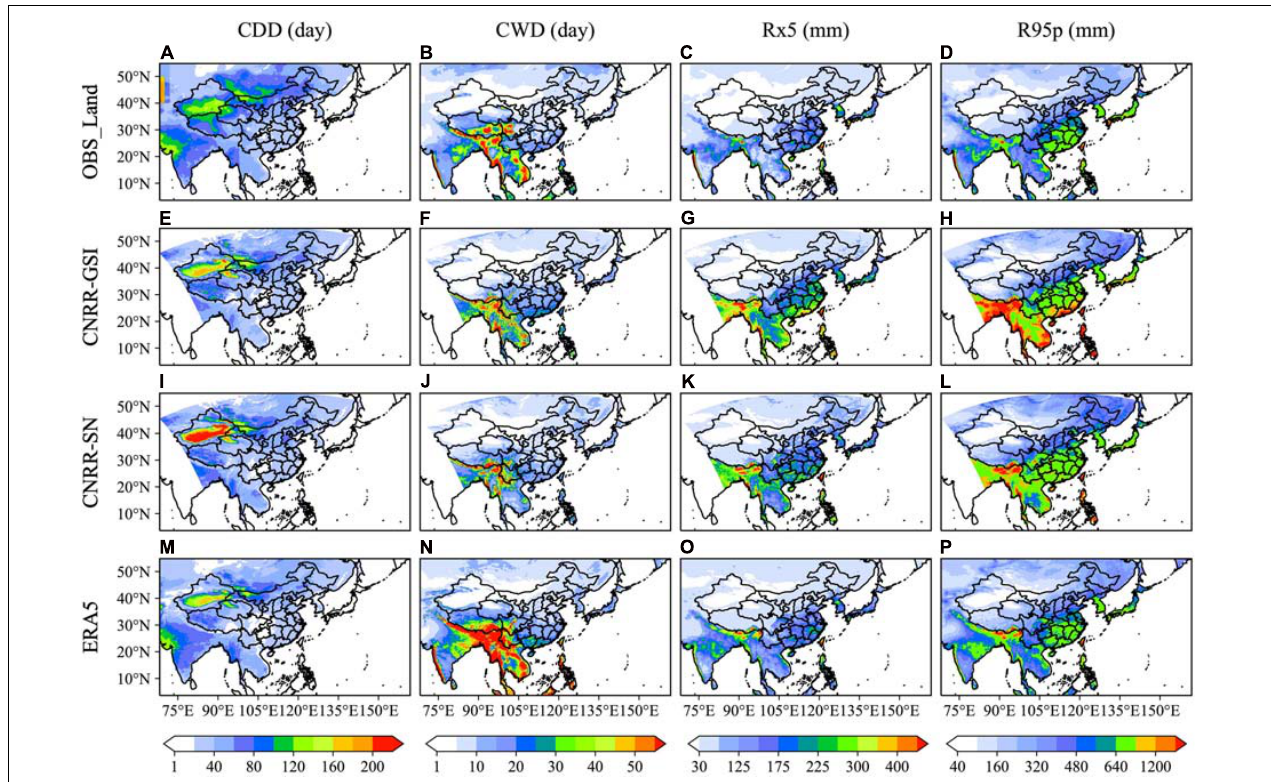
FIGURE 7 | Spatial distribution of the extreme rainfall indices (CDD, CWD, Rx5 and R95p) produced by OBS-Land (A–D) , CNRR-GSI (E–H) , CNRR-SN (I–L) and ERA5 (M–P) over land.